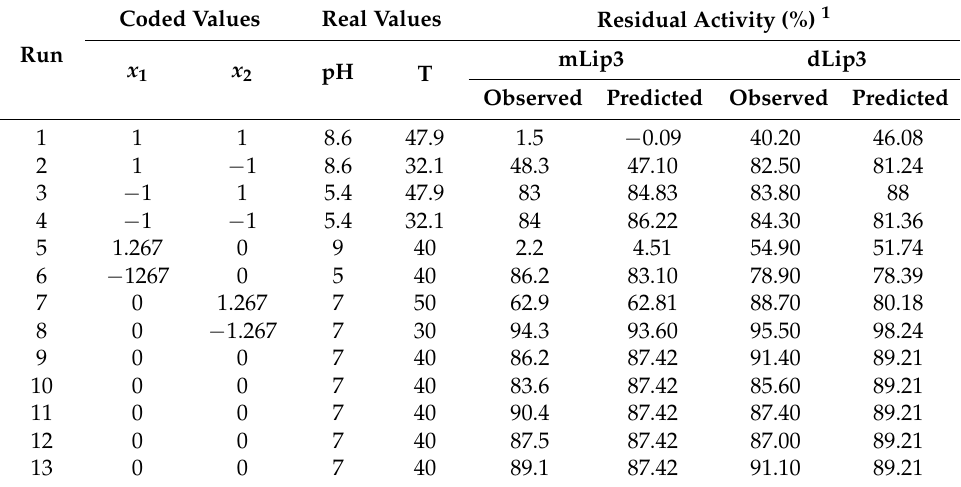
Table 2. Experimental design matrix and comparison of observed data and predicted from RSM. Coded Values Run